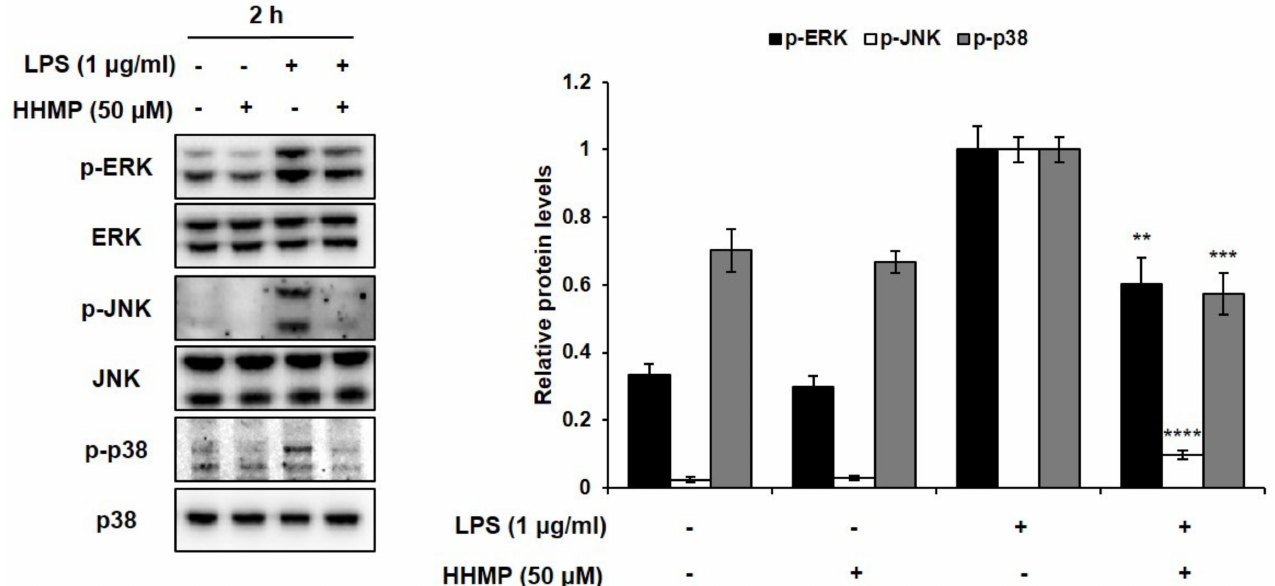
Figure 4. Effect of HHMP on LPS-induced MAPK activation in RAW 264.7 cells. Cells were pre-treated with HHMP (12.5, 25, and 50 µ M) and then treated with LPS for 2 h. Protein levels were determined using Western blot analysis. +: added in the cells; -: not added in the cells. All experiments were performed in triplicate, and the results are expressed as the mean ± standard deviation (SD); * p < 0.05, ** p < 0.01, *** p < 0.001, and **** p < 0.0001 compared with the LPS- stimulated